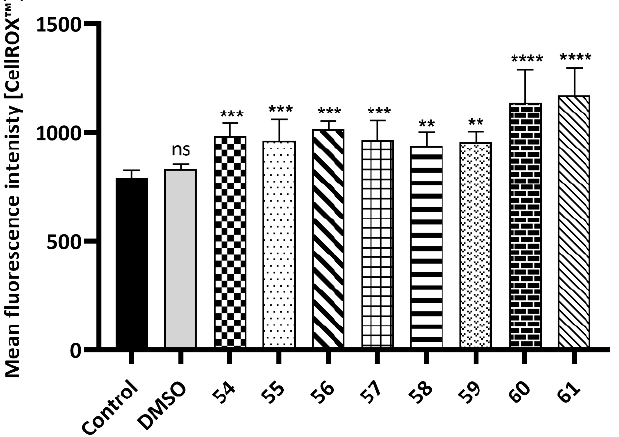
Figure 5. Intracellular ROS production in HepG2 cells after treatment with the analyzed compounds 54 (5.5 µ M), 55 (3.4 µ M), 56 (12 µ M), 57 (3.1 µ M), 58 (3.9 µ M), 59 (5.4 µ M), 60 (31 µ M), and 61 (4.8 µ M). The concentration chosen for each compound corresponded to the total IC 50 value. Oxidative stress was evaluated using CellROX Deep Red Reagent by flow cytometry. Data are presented as the mean ± SD of three independent experiments. Statistical significance is indicated with asterisks: (ns) p > 0.05, (**) p < 0.01, (***) p < 0.001, and (****) p < 0.0001.